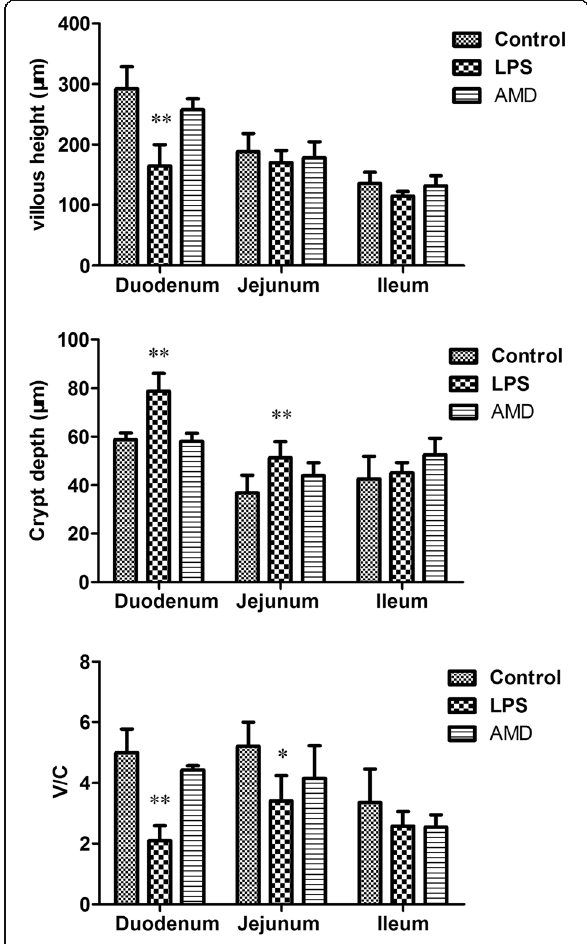
Fig. 3 Effects of AMD on VH (villus height), CD (crypt depth) and V/ C (villus height /crypt depth), in the duodenum, jejunum and ileum of mice. The data are expressed as the mean ± SD ( n = 10 per treatment group). Values are significantly different from controls (* P < 0.05, ** P <